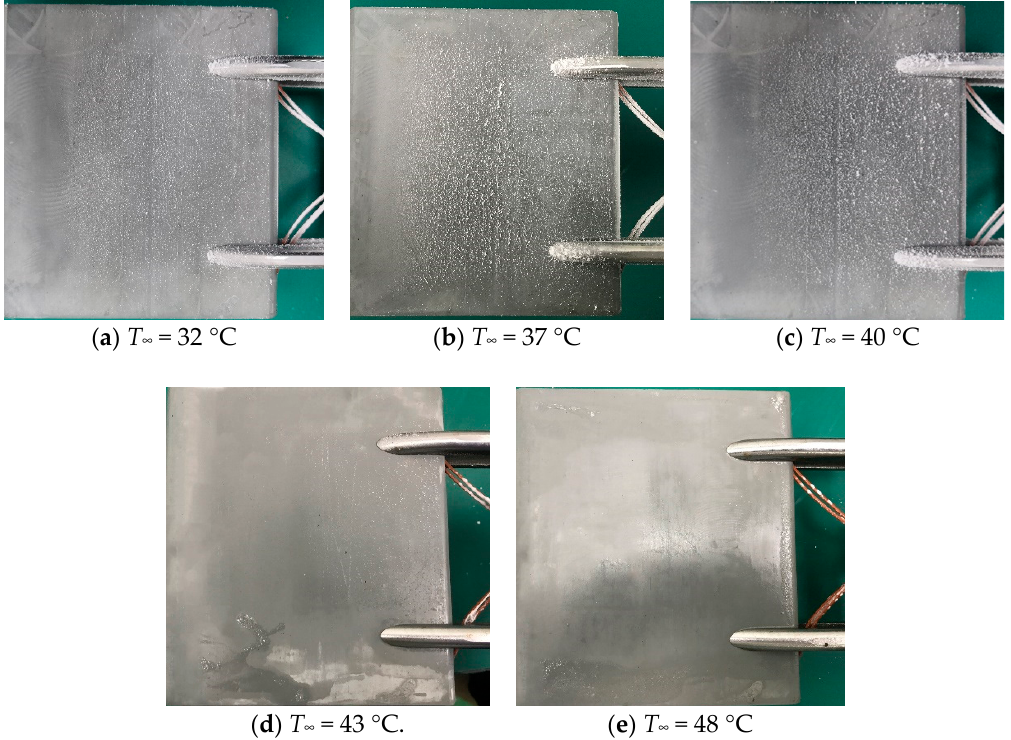
Figure 16. Photographs of wax deposition on lee surface with different mainstream temperatures.